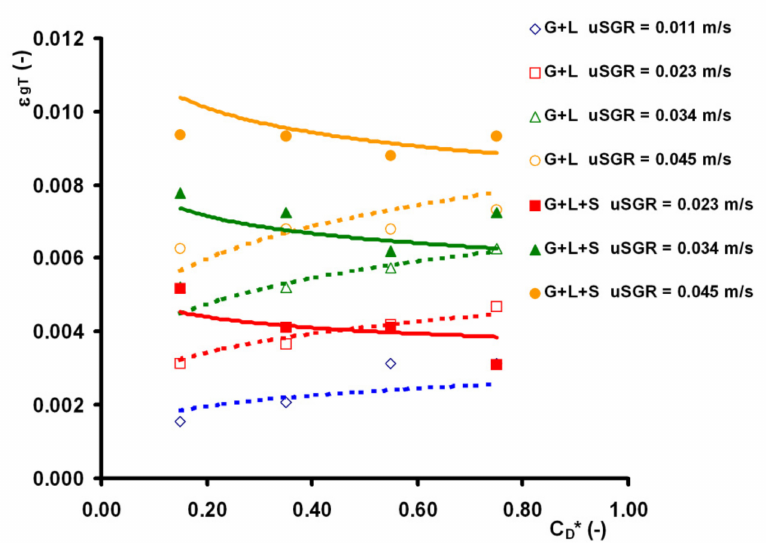
Figure 2. Total gas holdup GT : Effect of dimensionless deflector clearance: Gas–liquid system (empty symbols), gas–liquid–solid system (full symbols), correlation (4) for gas–liquid system (dotted line), correlation (4) for gas–liquid–solid system (full